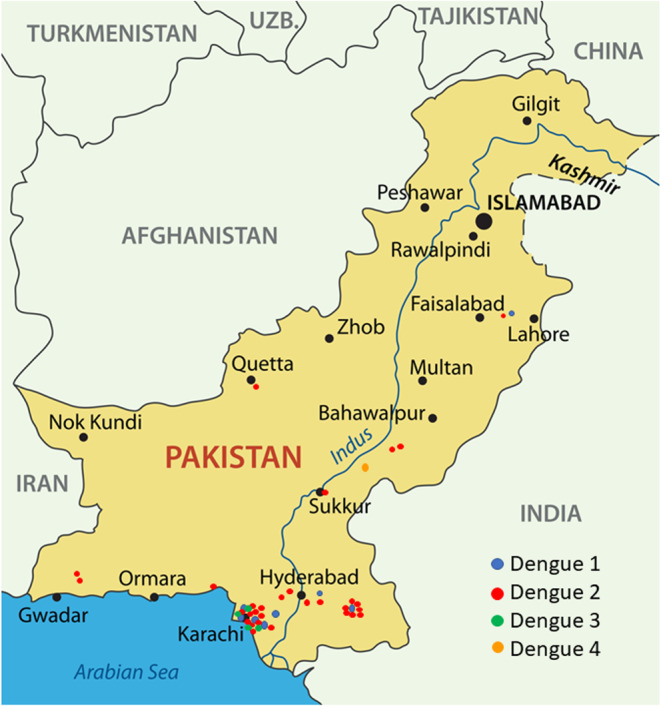
The locations of subjects infected with dengue virus during 2015–2017. The majority of cases were identified from Karachi.